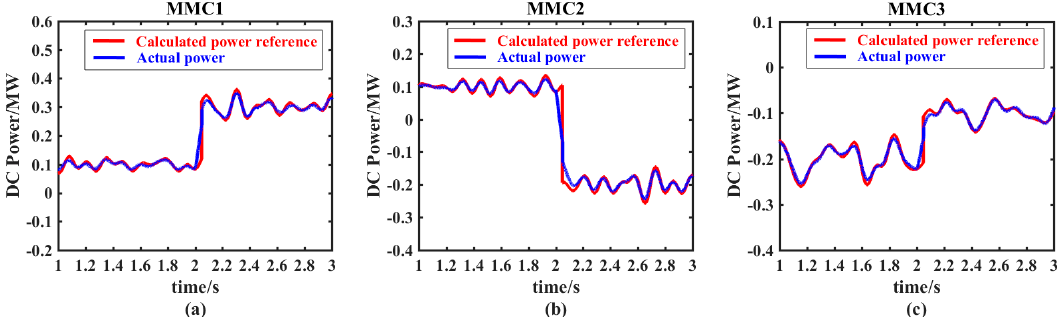
Figure 9. Calculated and actual power of the HESS. ( a ) Battery1; ( b ) Battery2; ( c ) Battery3; ( d ) SMES. According to the proposed control scheme, the MMCs not only exchange power among the microgrids, but also transmit the high frequency fluctuating power of the sub-microgrids to the SMES for central suppression. At the same time, the batteries suppress the low frequency fluctuating power of the sub-microgrids locally. As Figure 8 and 9 show, even though the power oscillates frequently and fast during the dispatch periods, the MMCs adaptively track the calculated power references via the adaptive droop control and the calculated power references of the batteries and the SMES are also well tracked in the simulation. It indicates that both the MMCs and the HESS work appropriately and effectively as the proposed control scheme requires. This is also verified by the power deviations of the MMCs and the HESS listed in Table 4. As a result, flat AC tie-line power is achieved and the power fluctuation is suppressed owing to the effective coordination among the MMCs and the HESS. 4.2. Limited Condition of the HESS 4.2.1. Limited Condition of the SMES When the SMES is under the “limited condition”, the SMES quits operation for self-protection and the high frequency fluctuating power of the sub-microgrids is suppressed locally by the